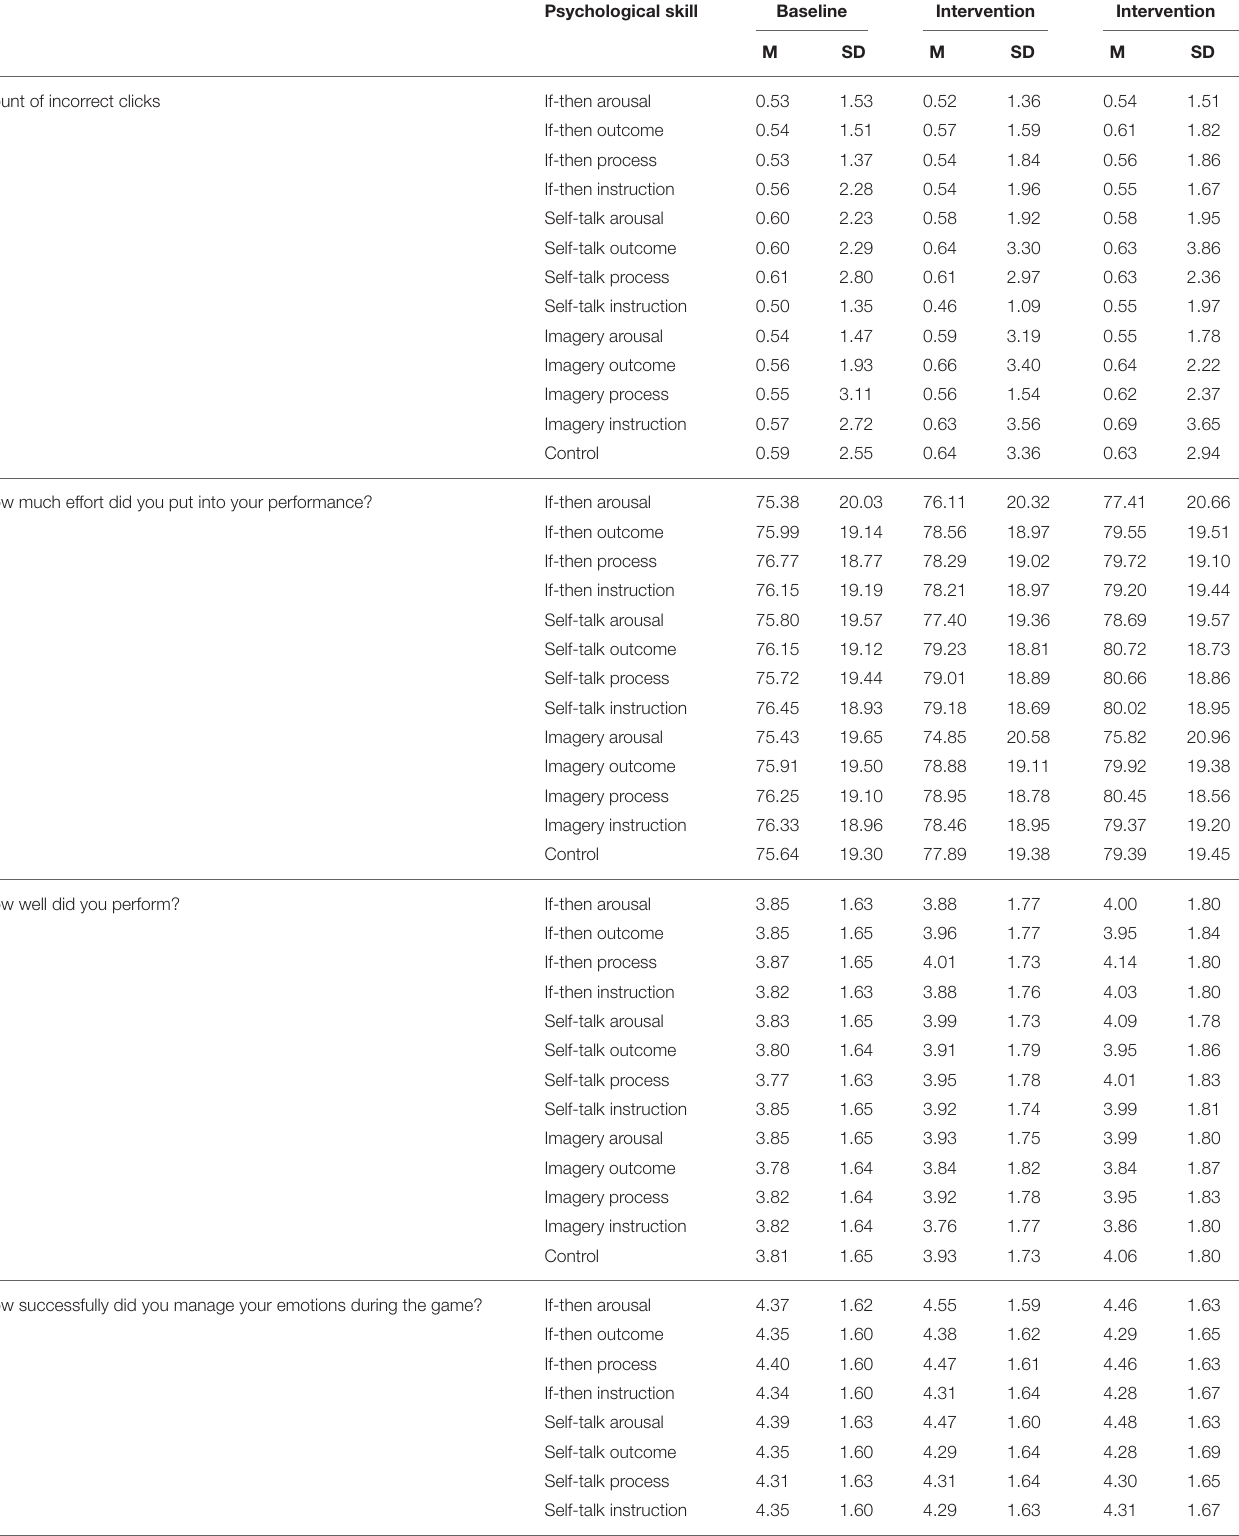
TABLE 5 | Descriptive statistics for performance, effort, arousal and emotion by intervention